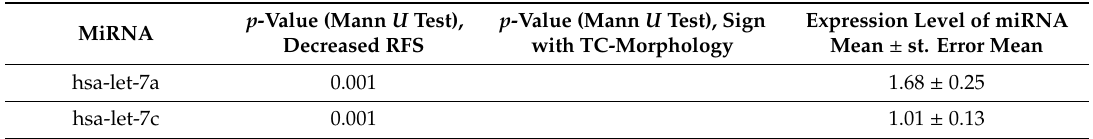
Table 1. MiRNAs associated with decreased RFS (relapse free survival) and with TC (tall cell) morphology